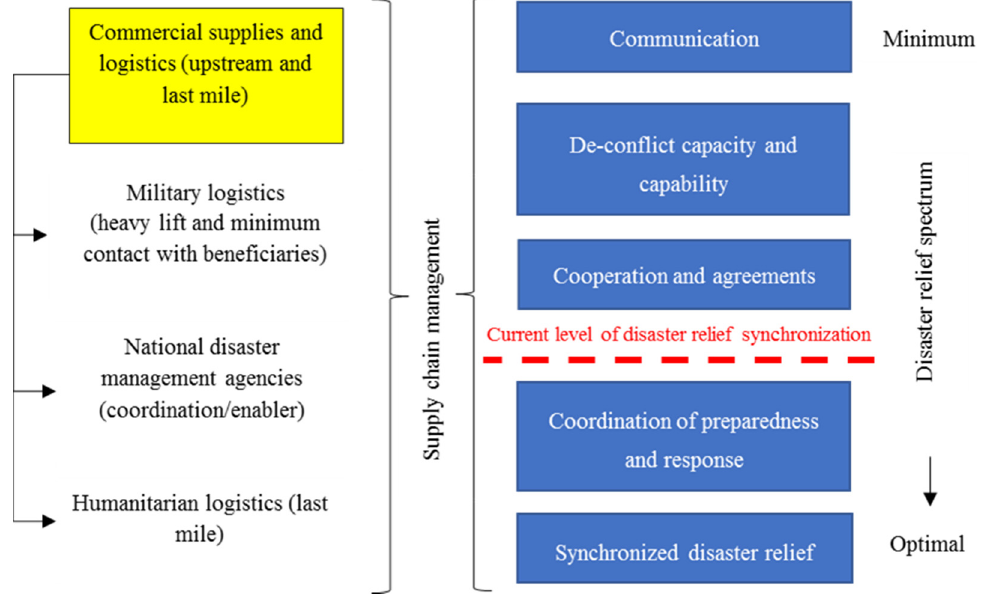
Figure 2. Conceptual framework for synchronized disaster relief.